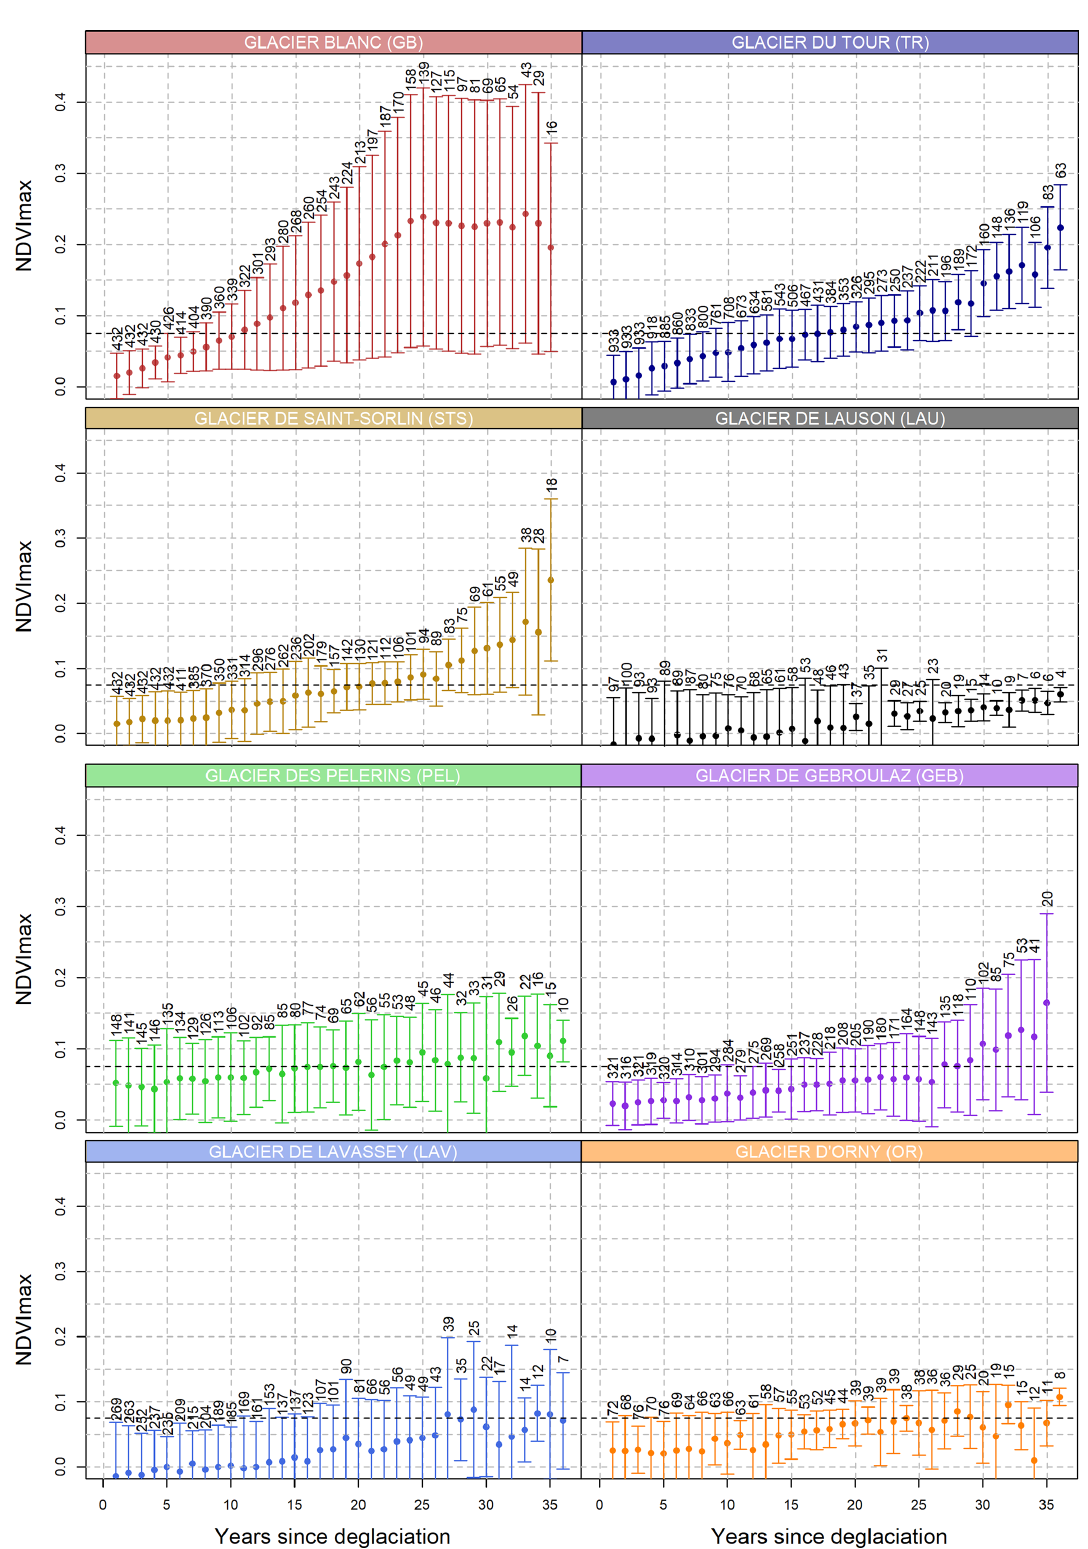
Figure 4. Distribution of NDVImax values according to the number of years since deglaciation for the eight glacier forefields. Error bars indicate standard deviation and numbers indicate the numbers of pixels for a given number of years since deglaciation. Horizontal dashed lines show an NDVI of 0.075. Numbers of pixels for each year since deglaciation are indicated above each error bar.